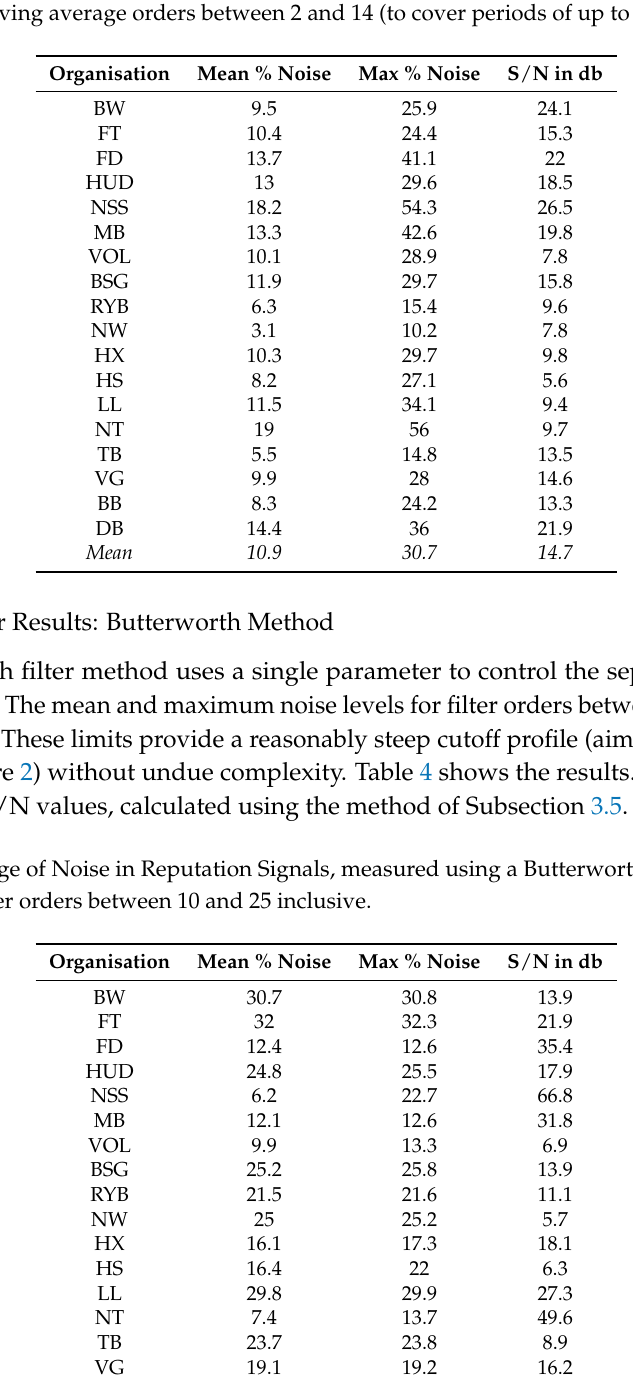
Table 3. Percentage of Noise in Reputation Signals, measured using a Moving Average Filter. The results are means for moving average orders between 2 and 14 (to cover periods of up to two weeks).